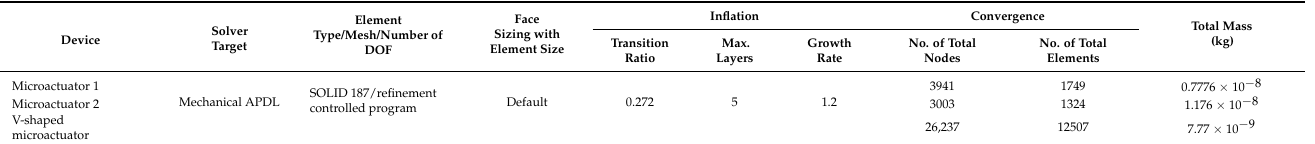
Table 6. Technical details about FEA in Ansys Workbench for microactuators 1 and 2, and the V-shaped